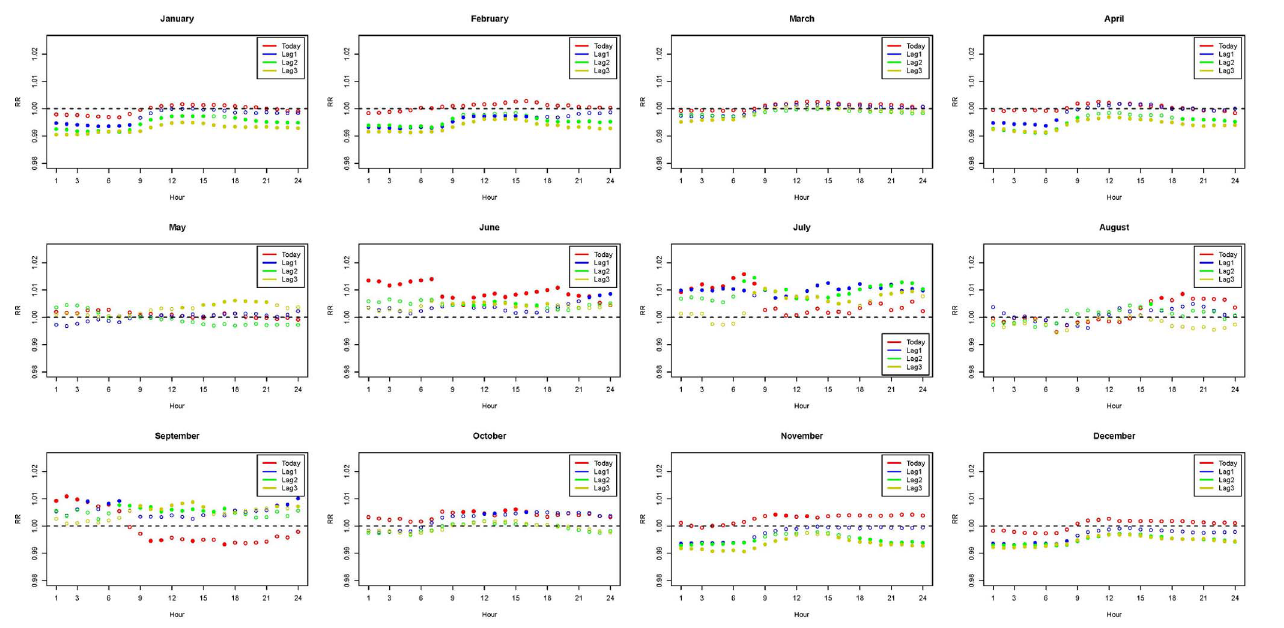
Figure 4. Distribution of hourly relative risk in the total population. (Abbreviations: max, maximum; min, minimum; RR, relative risk; diff, daily range; T 5am , temperature at 5 am; T 8am , temperature at 8 am.) Models were adjusted for daily mean of ozone exposure, city effects, calendar year, daily relative humidity, and